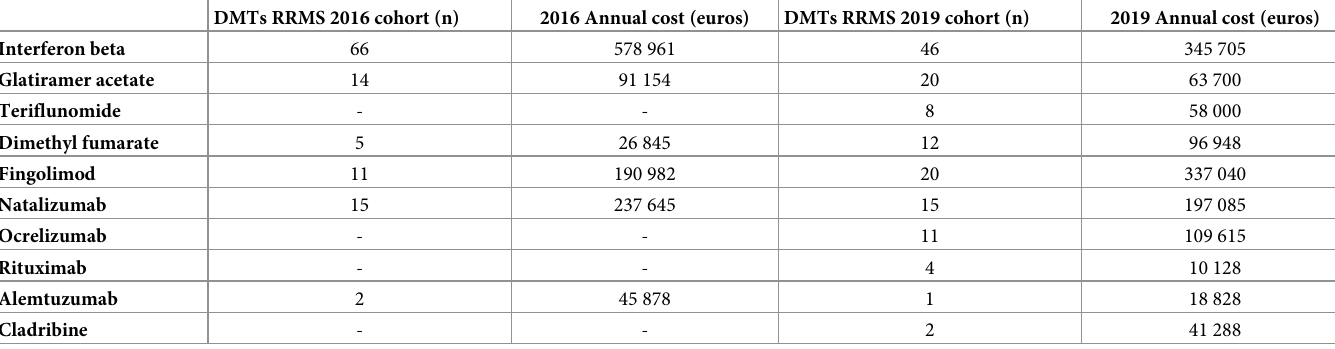
Table 2. DMTs used by the patients with RRMS from the 2016 and 2019